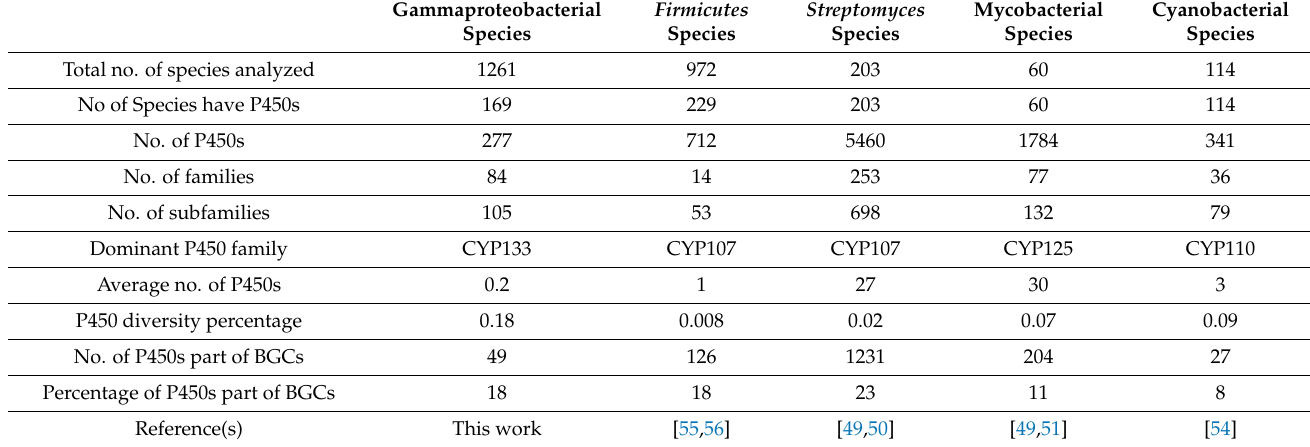
Table 2. Comparative analysis of key features of P450s and their association with secondary metabolism between Gammapro- teobacterial species and different bacterial species. BGCs: biosynthetic gene clusters.